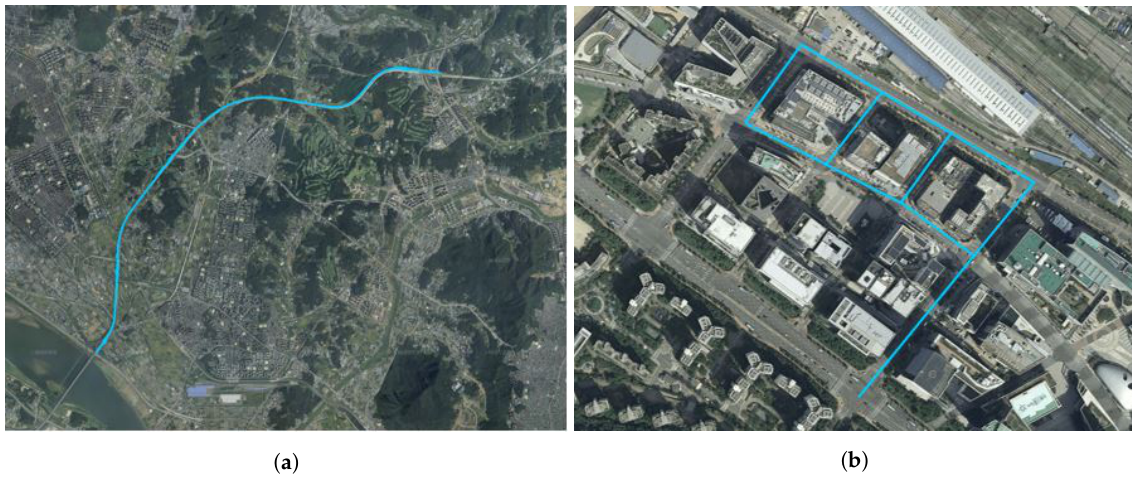
Figure 9. Overall map comprising of two courses: ( a ) course 1 (highway area); ( b ) course 2 (urban